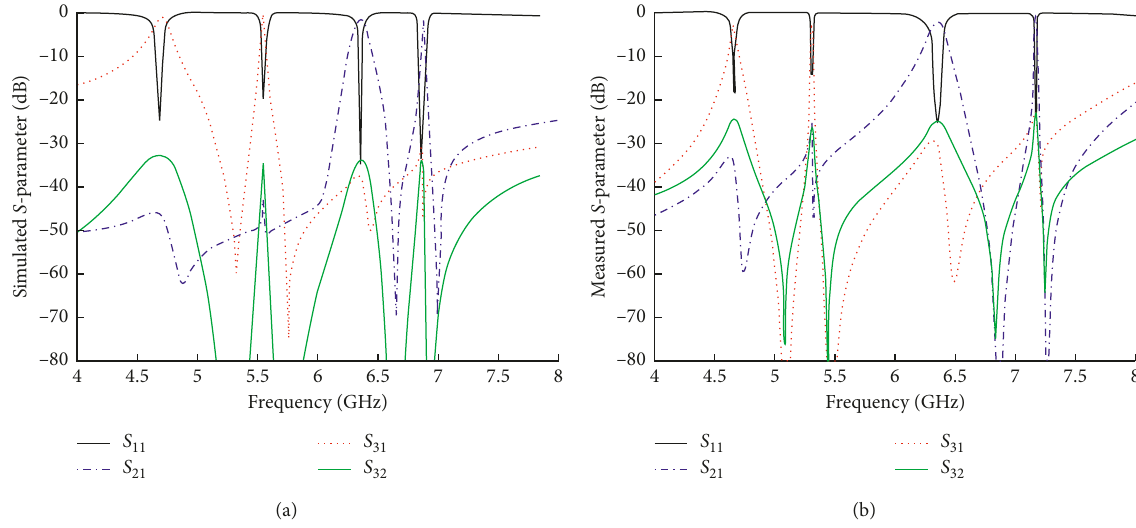
Figure 20: Measured and simulated transmission responses of the proposed diplexer [9].